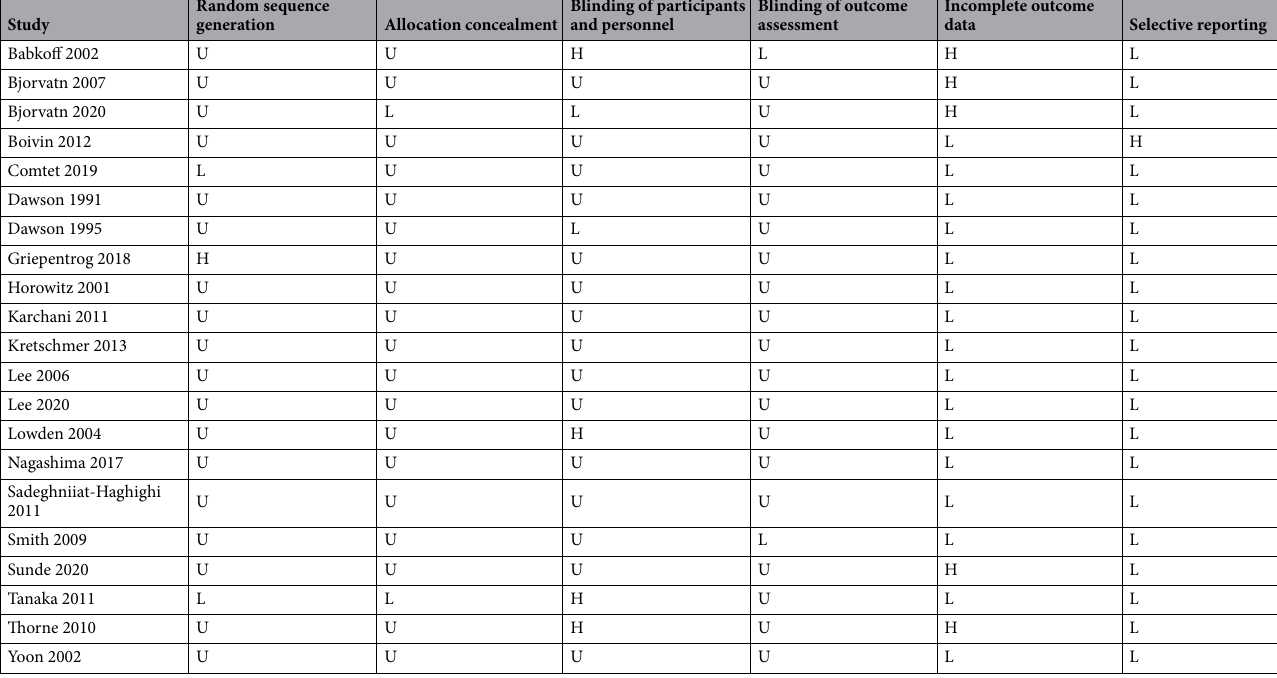
Table 3. Risk-of-Bias assessment of included studies. L low risk, H high risk, U unclear risk.